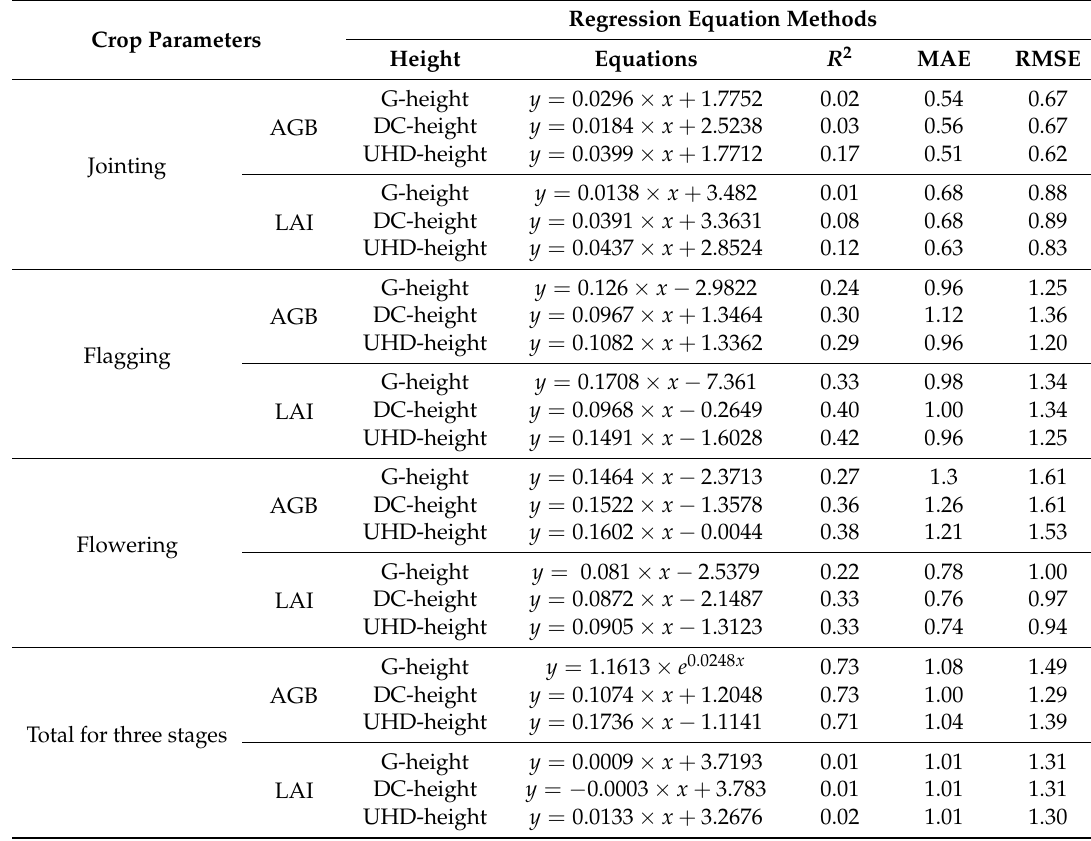
Table 5. Relationship between crop parameters and crop height in different growing stages.